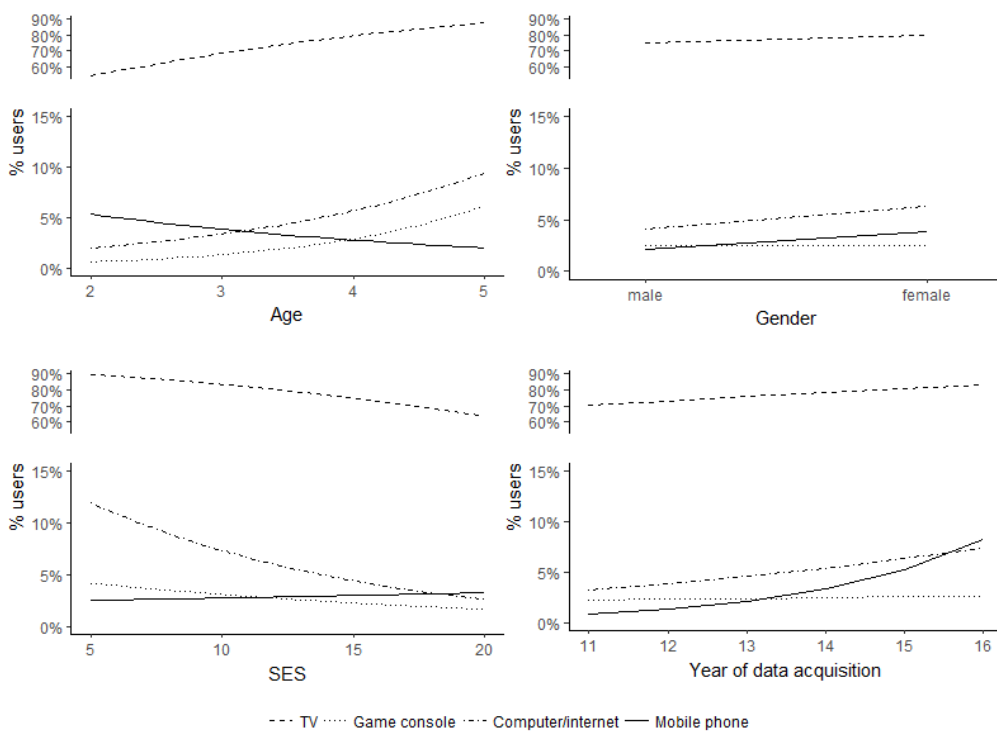
Figure 1. Effect plots for the associations of age, gender, socio-economic status (SES), and year of data acquisition with the use of different electronic media. The y-axis was modified due to differences in the usages of the different electronic